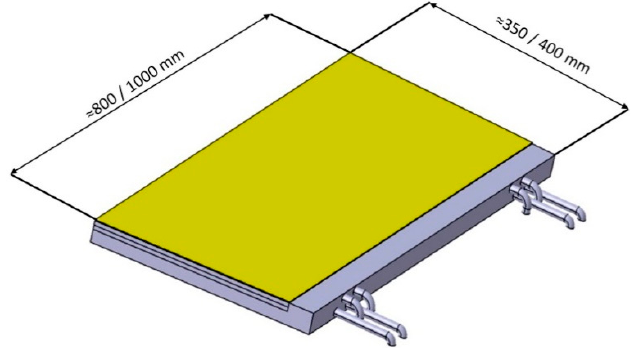
Figure 2. 2019 Divertor CAD Model: Reflector Plates [15].